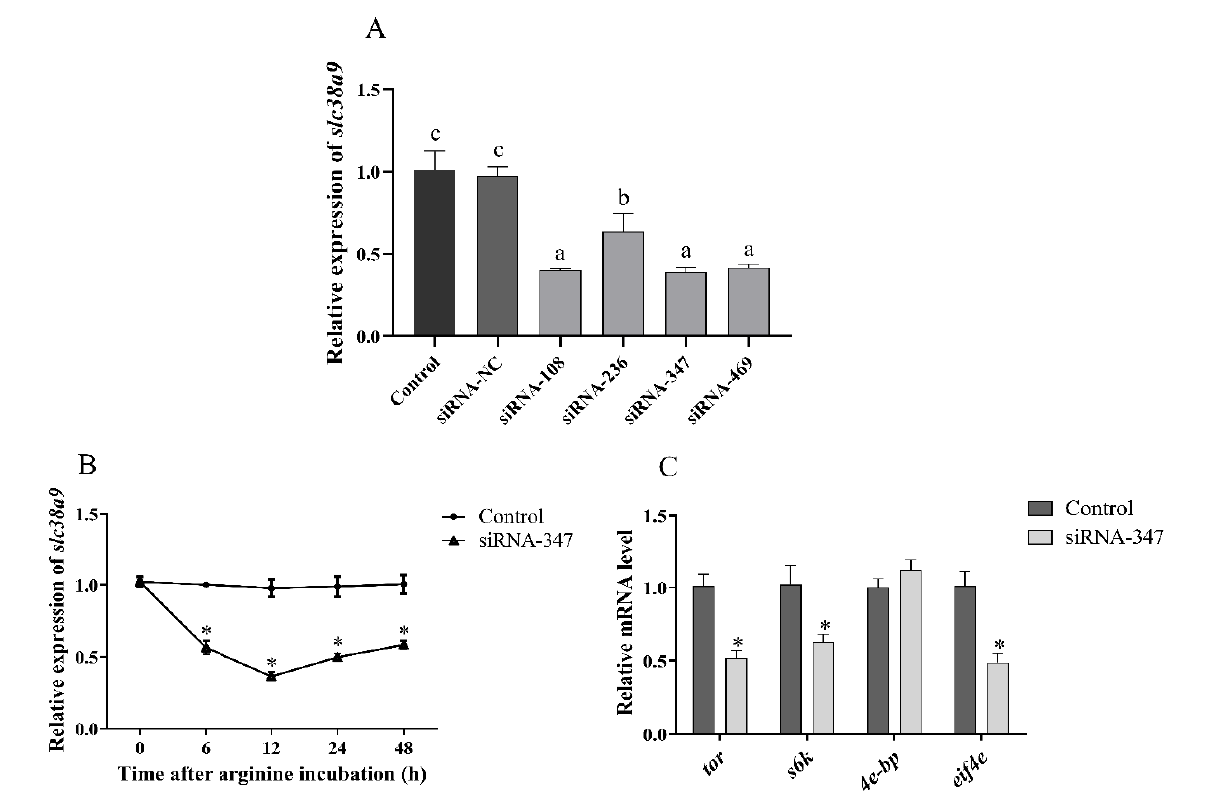
Figure 3. siRNA- slc38a9 inhibits the expression of slc38a9 and the TOR signaling pathway. ( A ) The relative expression levels of slc38a9 in the muscle of abalones after injection with siRNA. ( B ) The relative expression levels of slc38a9 in muscle at different time after injection with siRNA-347. ( C ) The relative expression levels of target of rapamycin ( tor ), ribosomal s6 protein kinase ( s6k ), eukaryotic translation initiation factor 4e binding protein ( 4e-bp ) and eukaryotic translation initiation factor 4e ( eif4e ) in muscle at 12 h after slc38a9 knockdown. Results are represented as mean ± SEM. Different lowercase letters (a < b < c) indicate significant differences among groups ( p < 0.05), and asterisk (*) indicates a significant difference between the control and the experimental group ( p < 0.05).